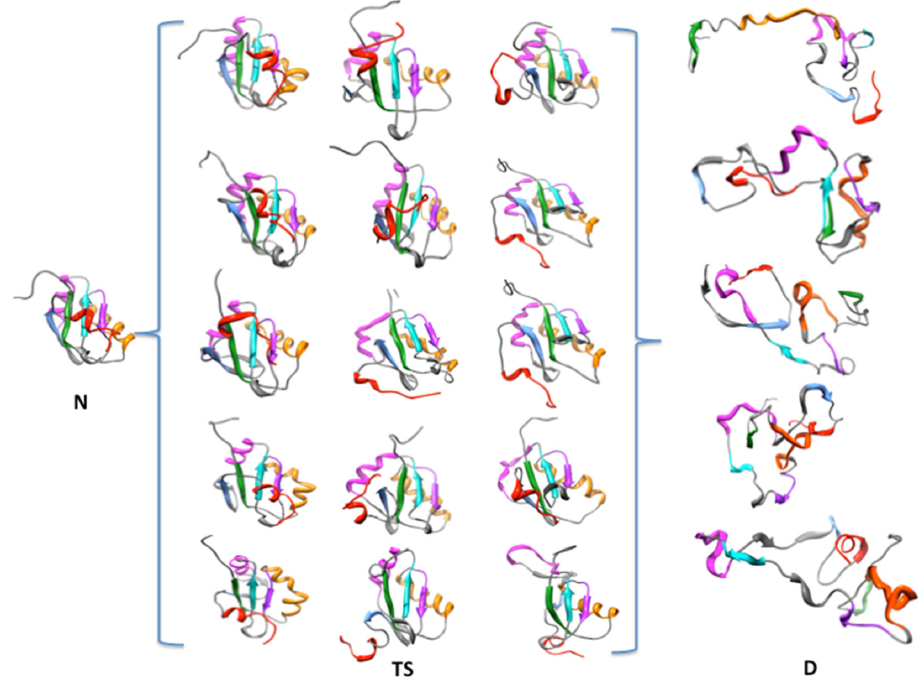
Figure 11. Results from 5 MDUF simulations: the brackets contain an ensemble of transition state structures.